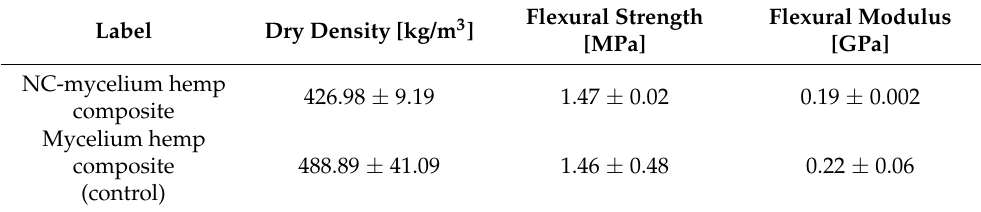
Table 1. Overview of the material properties in three-point bending of nanoclay–mycelium composites. The standard deviation is performed with triplicate specimens (mean ± one standard deviation).